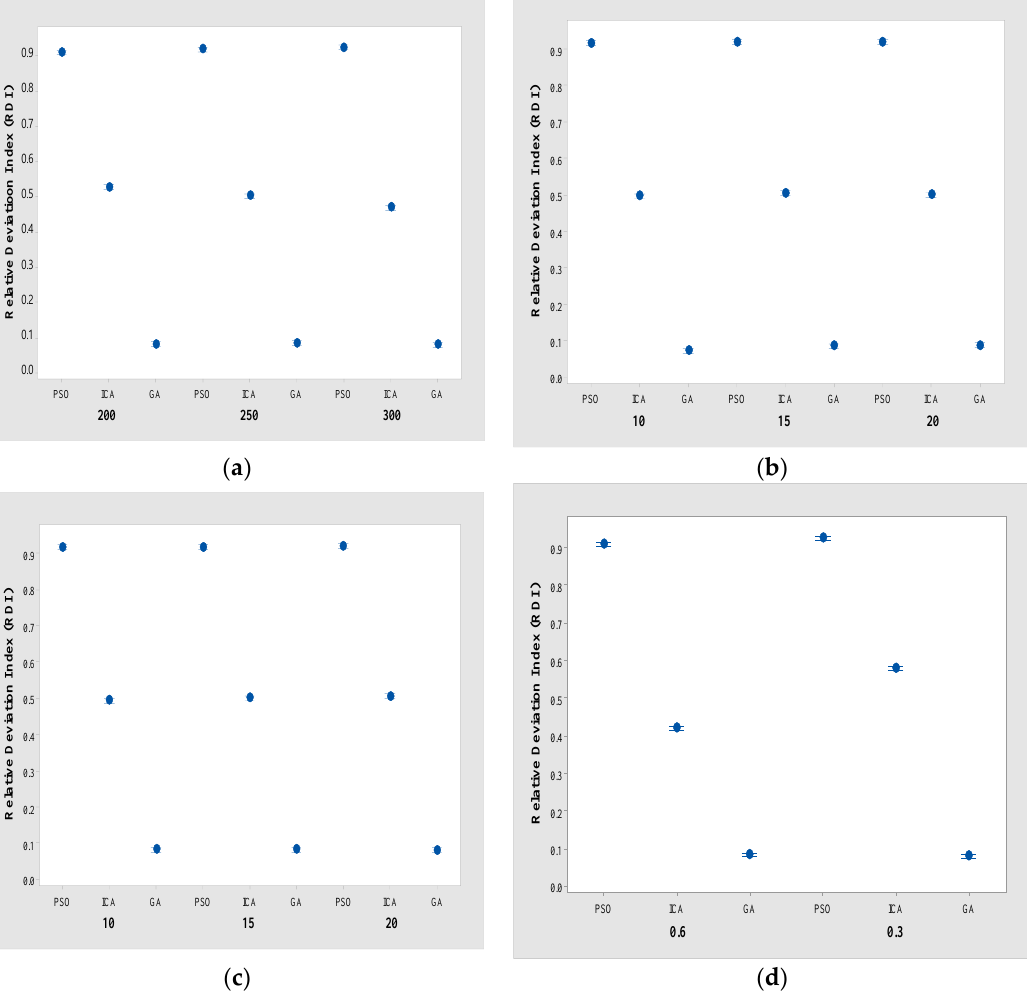
Figure 7. The mean plots and Tukey HSD intervals ( α = 0.05 ) for | J | , | T | , | C | , and δ groups. ( a ) | J | group. ( b ) | T | group. ( c ) | C | group. ( d ) δ